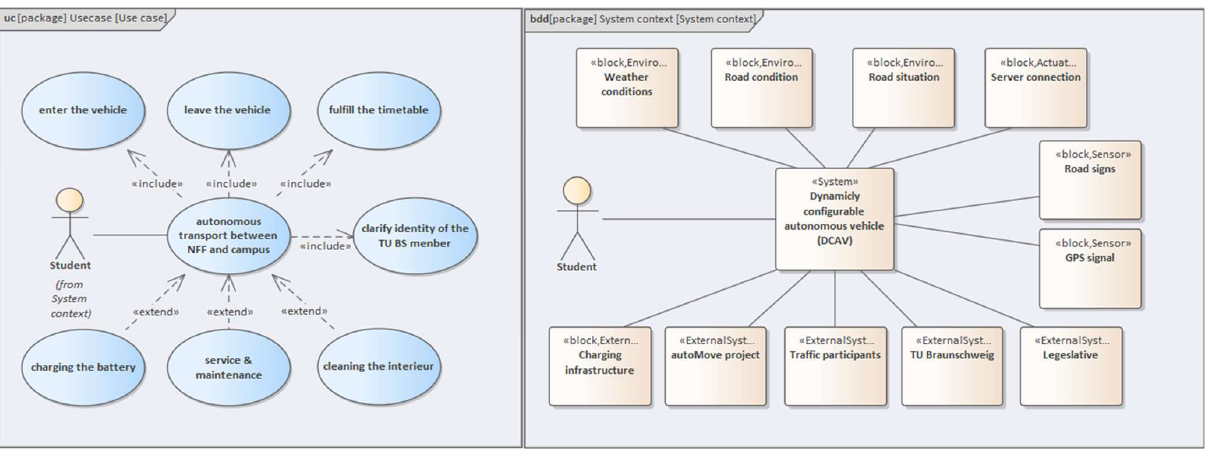
Figure 5. Use case and system context of the people